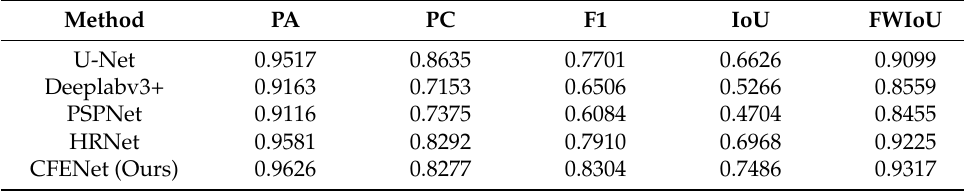
Table 2. Performance of different methods on the Massachusetts Building Dataset.